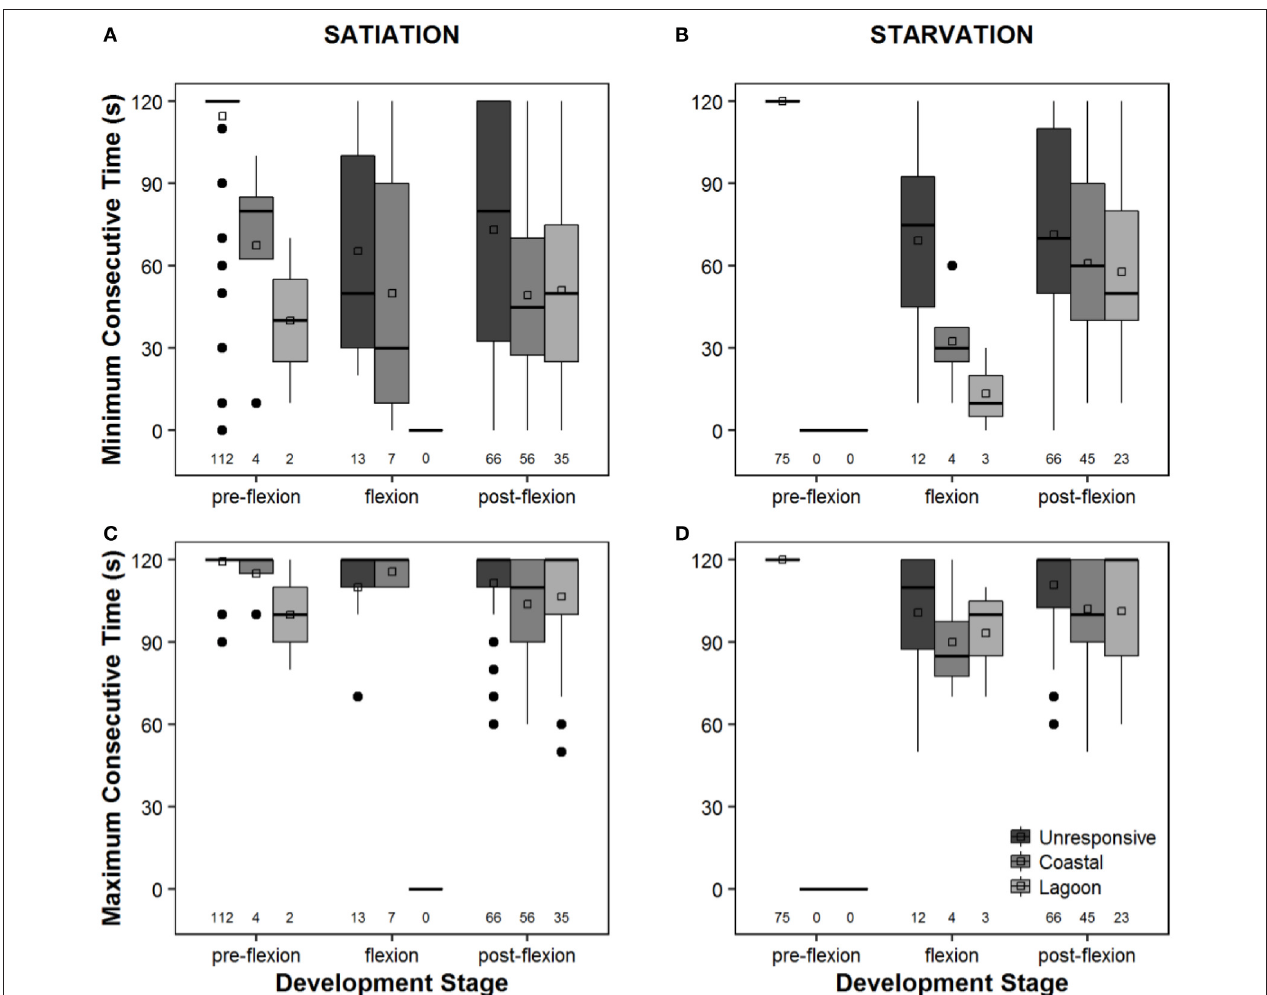
FIGURE 4 | Box-n-whiskers plots representing the minimum (A,B) and maximum (C,D) consecutive time (seconds) that Sparus aurata larvae spent exhibiting a given behavior (unresponsive, or preference for coastal or lagoon water), during choice-chamber trials performed along ontogeny (pre-flexion, flexion, post-flexion) and in satiation (A,C) and starvation (B,D) conditions. The behavior of each larva was assigned after two choice-chamber trials, and those larvae with inconclusive behavior were not considered in these analyses. The plot depicts the 1st and 3rd quartiles, median, mean, and outliers, as well as the 5th and 95th percentiles as the minimum and maximum whiskers, respectively. Legend: open squares represent the mean; thick black line represents the median; full black circles represent the outliers; the numbers at the bottom of the graph account for the number of observations